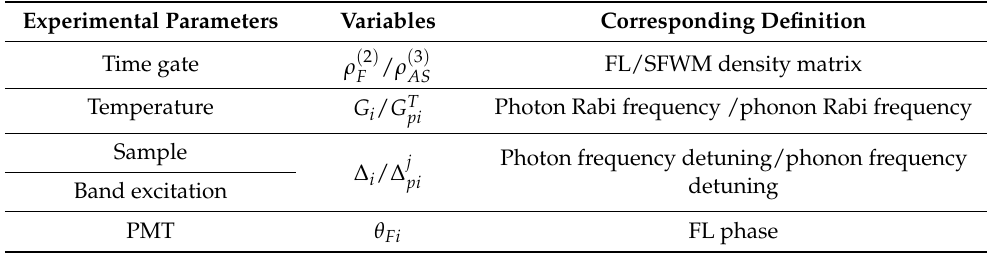
Table 1. Experimental parameters, Variables in the equations and Corresponding